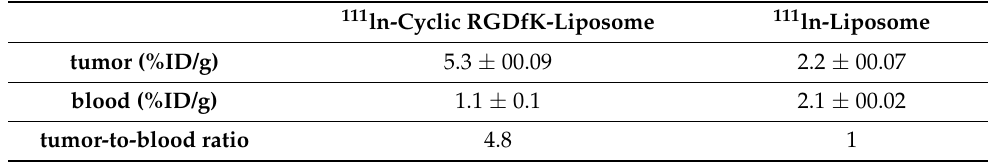
Table 1. The percentage of injection dose of the ln-111 cyclic RGDfK-liposome or the ln-111 liposome in the tissue samples and the radioactivity proportion of tumor to blood in the mice without a metastatic growth of human melanoma